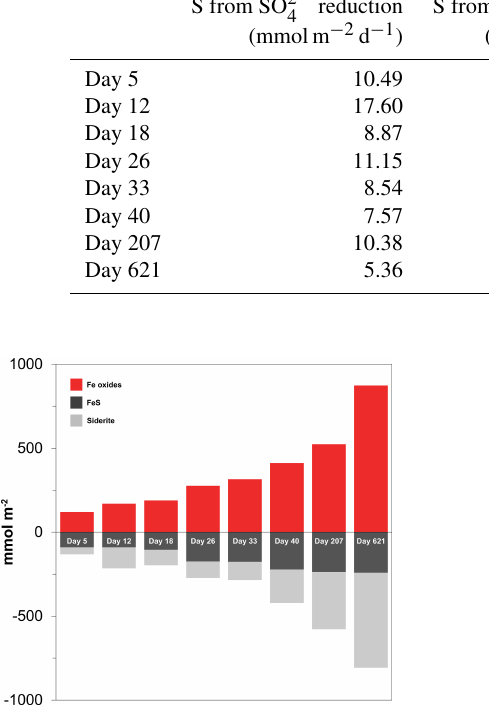
Figure 10. Time series of the depth-integrated (0–5cm) increase in Fe oxides (red) and the depletion of FeS (black) and siderite (grey) in mmolm − 2 . Negative values represent a decrease, whereas posi- tive values indicate an increase in the mineral